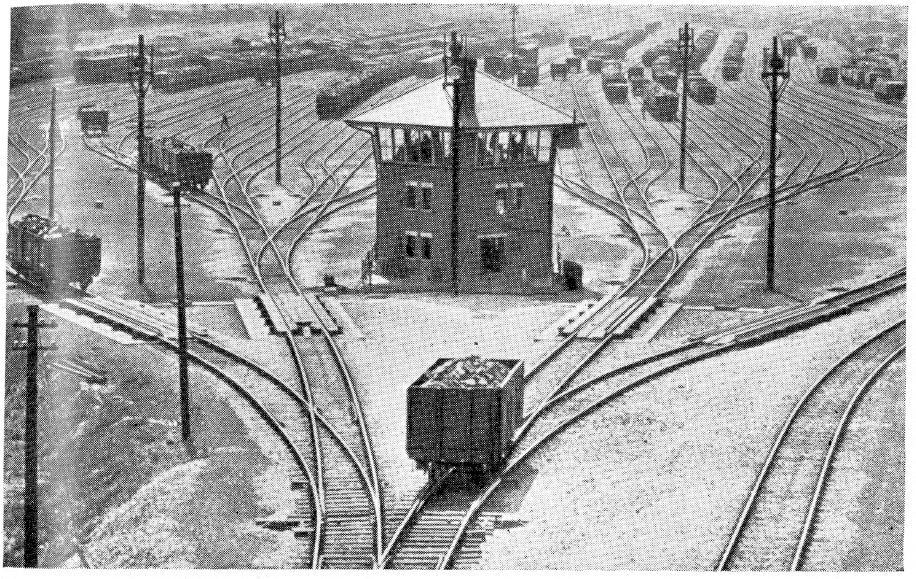
Figure 5 Whitemoor Marshalling Yard, L.N.E.R. , from Conrad H. Waddington, How Animals Develop (London: Allen and Unwin, 1935), 97 (photo: author).